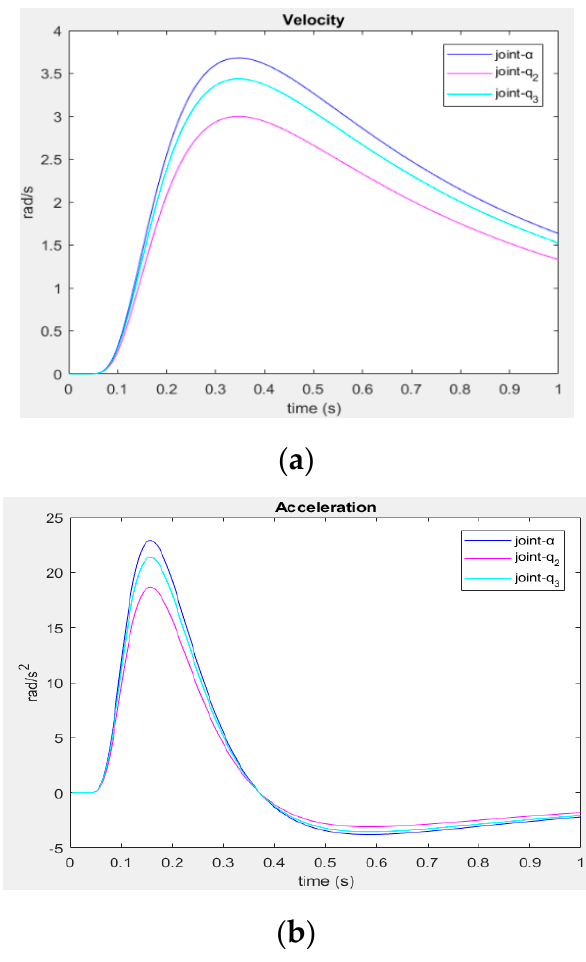
Figure 13. Example of a velocity and acceleration acquired on each joint in the fourth condition using − 1.5 ≤ a = a = a α ≤ 0 to obtain a smooth not curved-motion. ( a ) Velocity. ( b ) Acceleration.